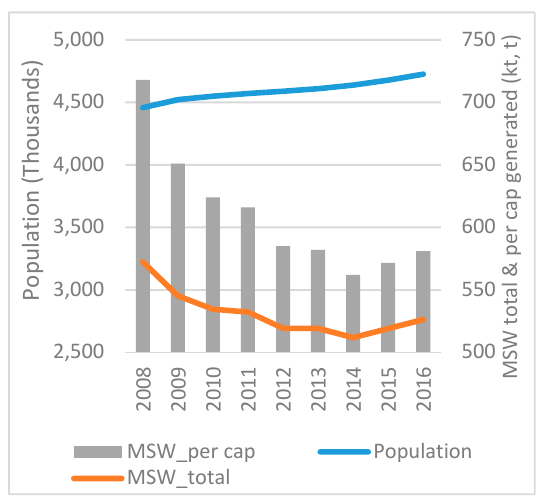
Figure 13. Population and MSW production in Ireland 2008–2017 (EUROSTAT 2019a, 2019c).